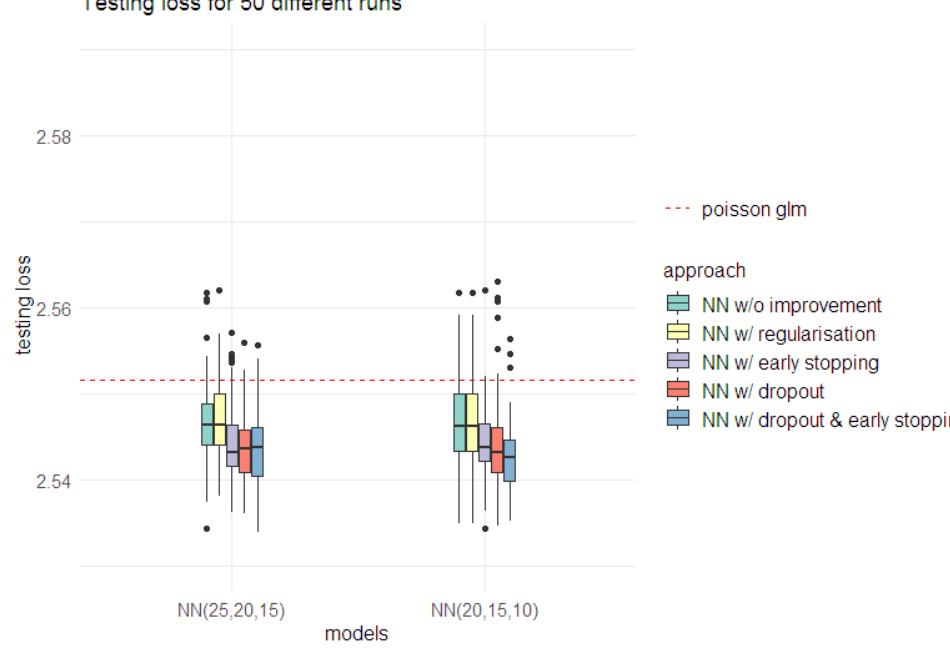
Figure 11. Performance from 50 different calibrations of the Poisson NN model under (25,20,15) and (20,15,10) architectures on testing and learning data sets for different model improvement